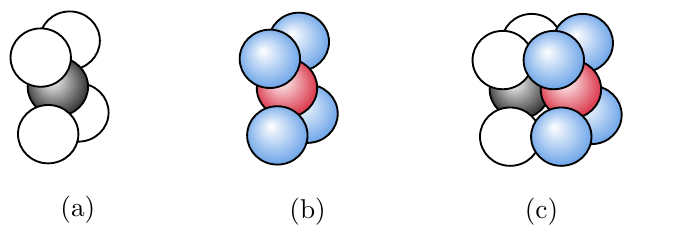
Figure 8 . (a) The crystal for e C 2 for the conifold C . (b) The same copy with different colours. (c) The crystal which is a disjoint union of (a) and